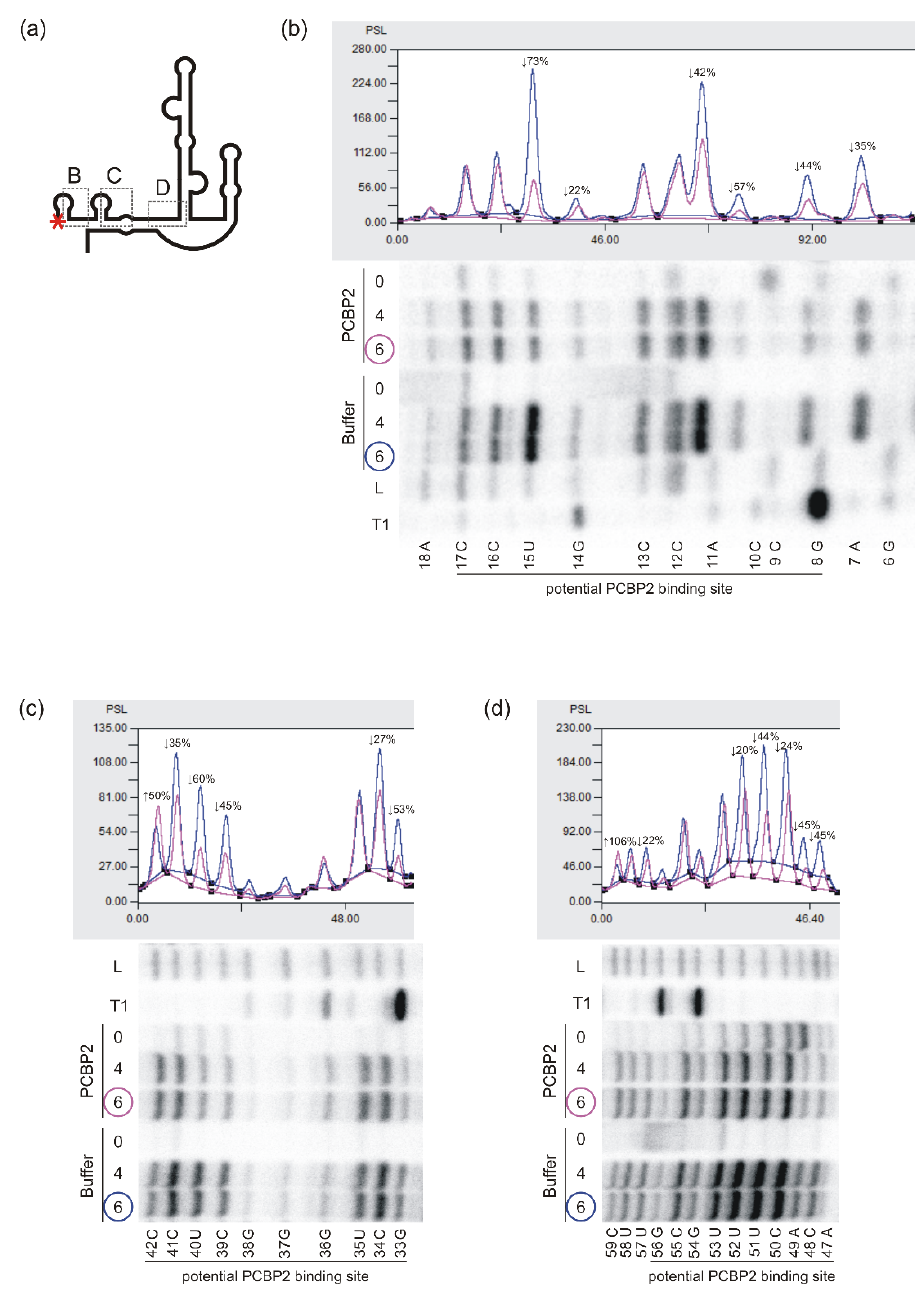
Figure 4. Structural probing of the P1- Δ 40p53 RNA in vitro in the presence of PCBP2 by Pb2+- induced cleavage method. ( a ) Schematic representation of the structure of the P1- Δ 40p53 RNA. The red asterisk denotes the 5 ′ -[32P]-end-labelling of RNA. The analysed regions of RNA are marked with dotted-line boxes named B, C and D. ( b – d ) Bottom panels: the autoradiograms show the products of Pb2+-ions induced cleavage reactions analysed on 12% polyacrylamide gels in denaturing conditions. The reactions were carried out at 37 °C with 4 and 6 mM Pb2+ ions for 3 min in the presence of PCBP2 or the buffer. Lanes: L, formamide ladder; T1, limited digestion by RNase T1 in denaturing conditions. Nucleotide residues are marked on the left side of each autoradiogram. Black lines along the gels indicate potential PCBP2 binding sites. Upper panels: normalised reactivities of Pb2+-induced cleavage (6 mM Pb2+ concentration) as a function of nucleotide position.